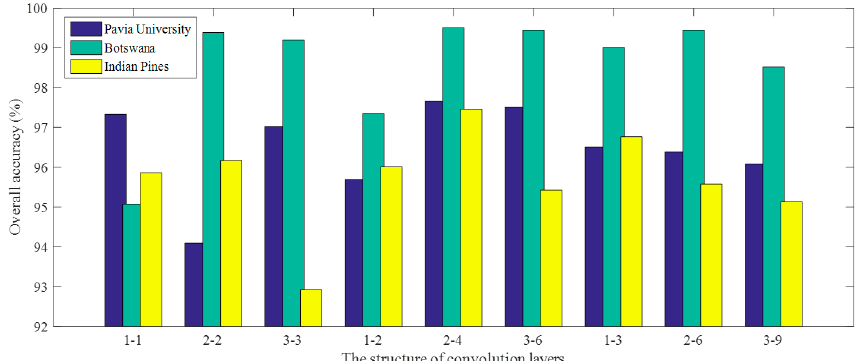
Figure 14. Overall accuracy by varying the number of kernels for the two convolution layers.